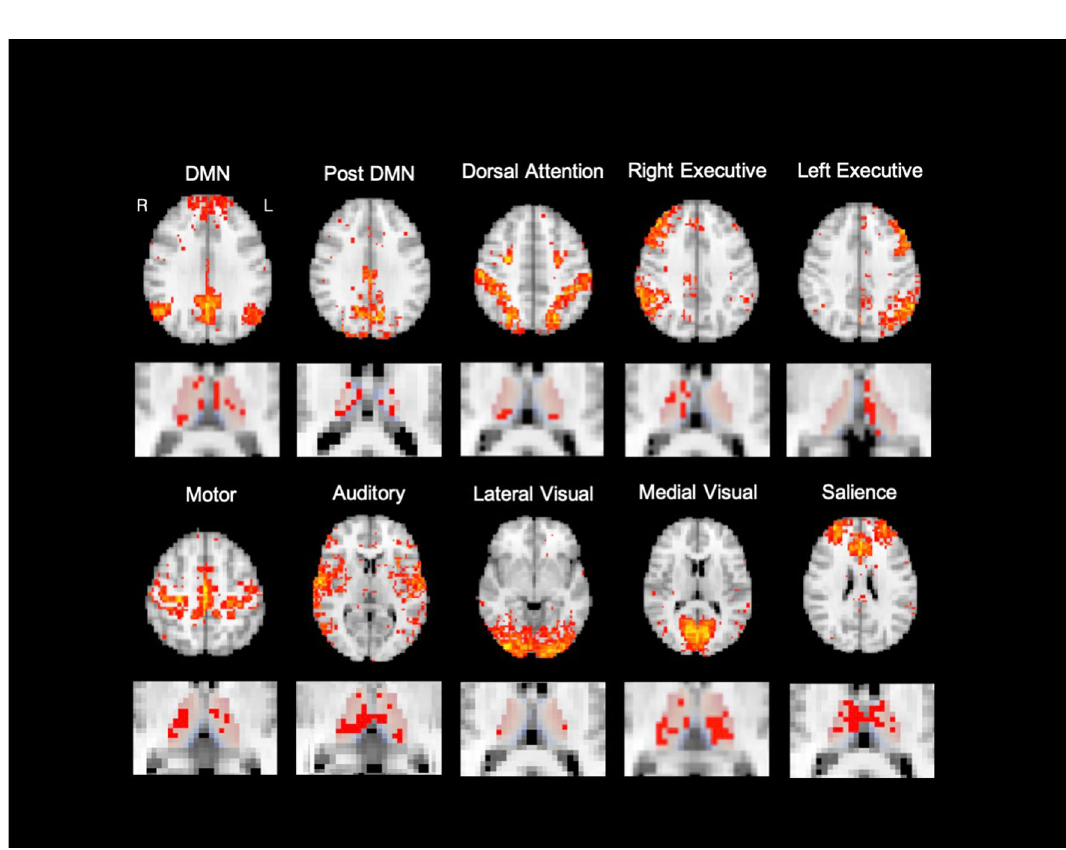
Figure 1. Thalamus-related cortical networks identified from ICA and the associated thalamic subdivisions for 10 representative cortical